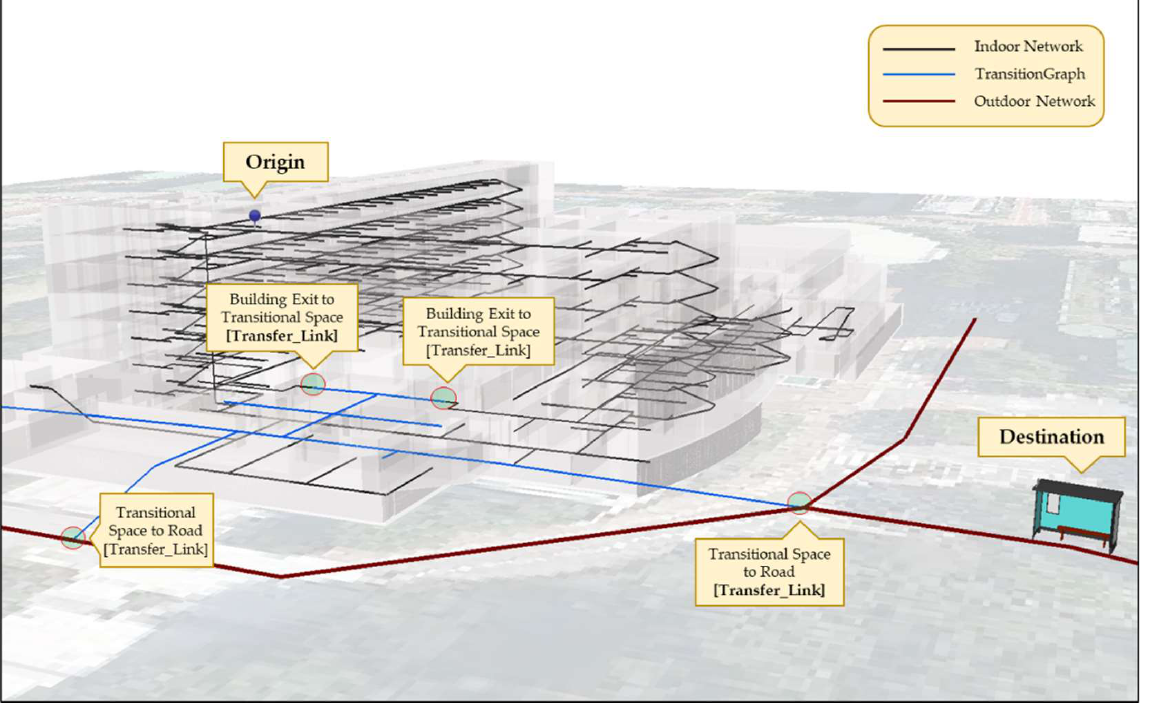
Figure 13. Origin and destination points for the route analysis.